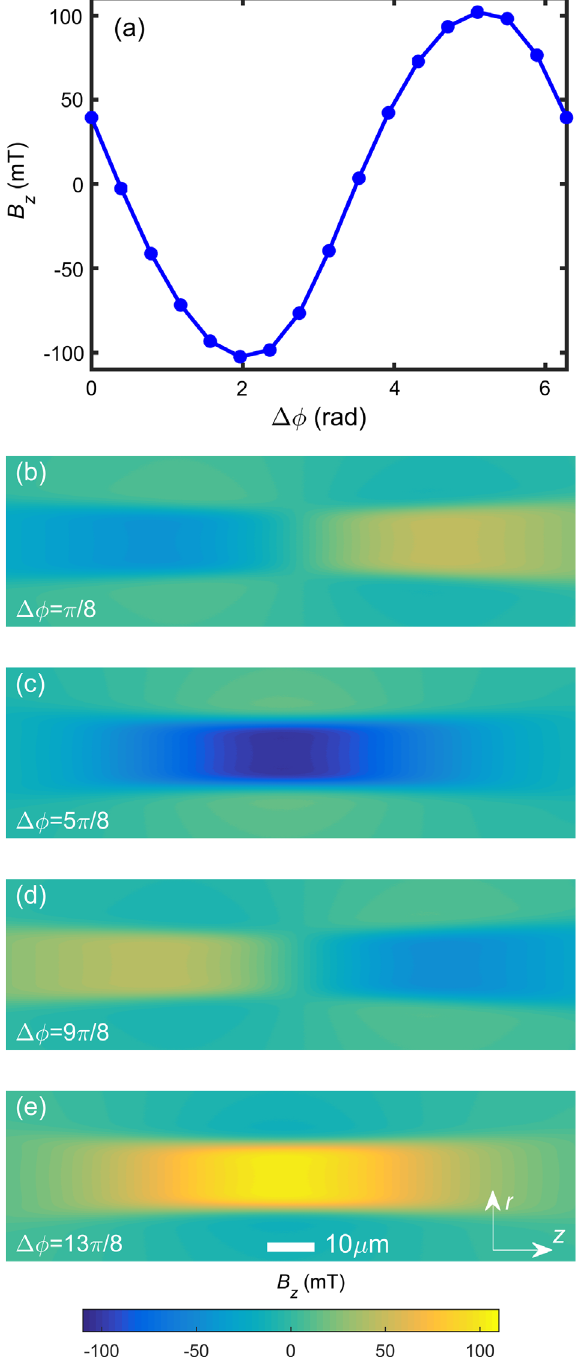
FIG. 3. Coherent control of magnetic fields. Simulation results for a beam waist w 0 ¼ 6 μ m, fundamental wavelength λ ¼ 4 μ m, medium thickness L ¼ 300 μ m, equal ω = 2 ω pulse durations τ ¼ 40 fs, and gas density n ¼ 10 17 cm − 3 . (a) Adjusting the p i phase offset between the ω and 2 ω beams enables precise control of the direction and amplitude of the generated magnetic field. In addition, the relative phase influences the spatial distribution of the magnetic fields. Longitudinal slices of the magnetic fields generated in the focusing geometry are shown for (b) Δ φ ¼ π = 8 , (c) Δ φ ¼ 5 π = 8 , (d) Δ φ ¼ 9 π = 8 , and (e) Δ φ ¼ 13 π = 8